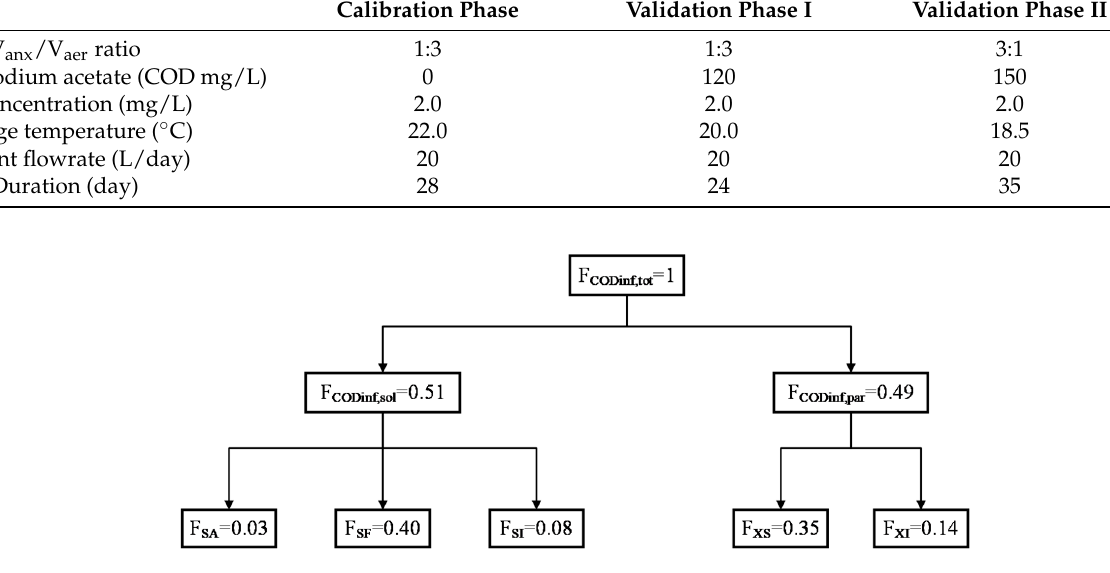
Figure 1. Fractionation of influent COD for the modeling of the lab-scale AAO system. Table 1. DOPs of the lab-scale AAO system.